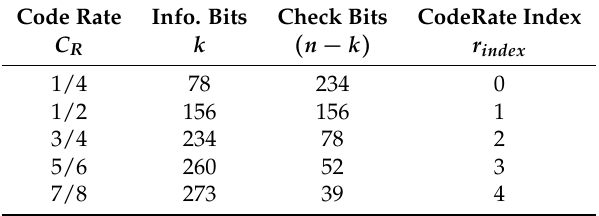
Table 1. Different data rates C R for LDPC (low density parity check), code length n =